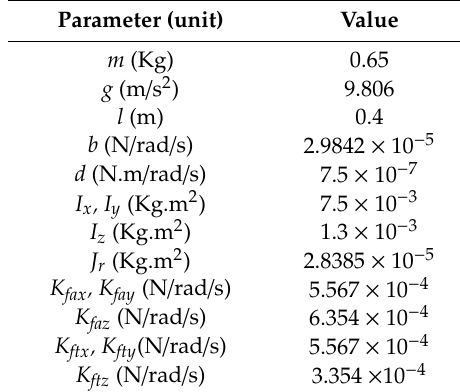
Table 1. Quadrotor’s parameters.